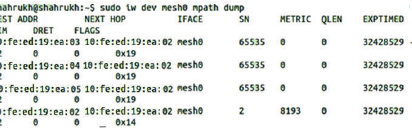
Figure 5: Path establishment using MAC